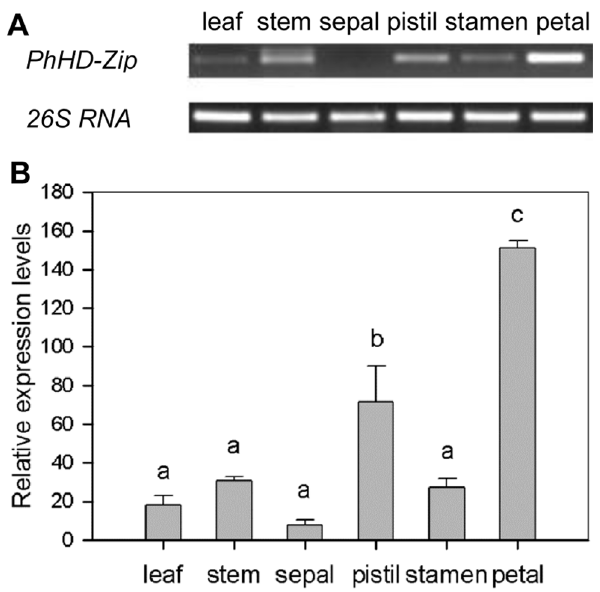
Figure 2. Expression of PhHD-Zip in different tissues of petunia. A. A representative gel image from semi-quantitative PCR of RNA isolated from different tissues. 26S RNA: the internal control. Samples were analyzed after 33 cycles for PhHD-Zip , and after 24 cycles for 26S RNA . B. Relative expression levels of PhHD-Zip in different tissues (quantification of the gel pictures; error bars show SE of the means of three biological replicates; different letters denote significant differenc- es using Duncan’s test at P , 0.05).